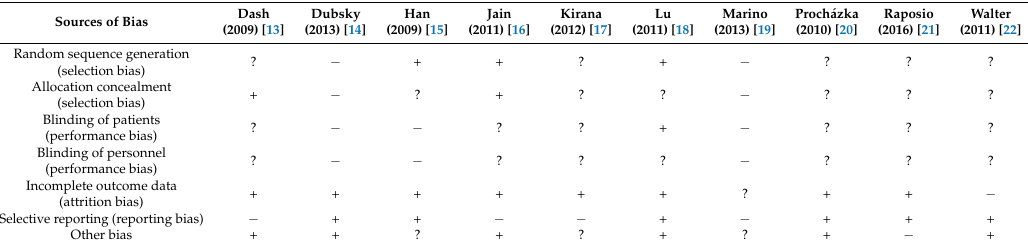
Table 3. Risk of bias summary for cell therapies